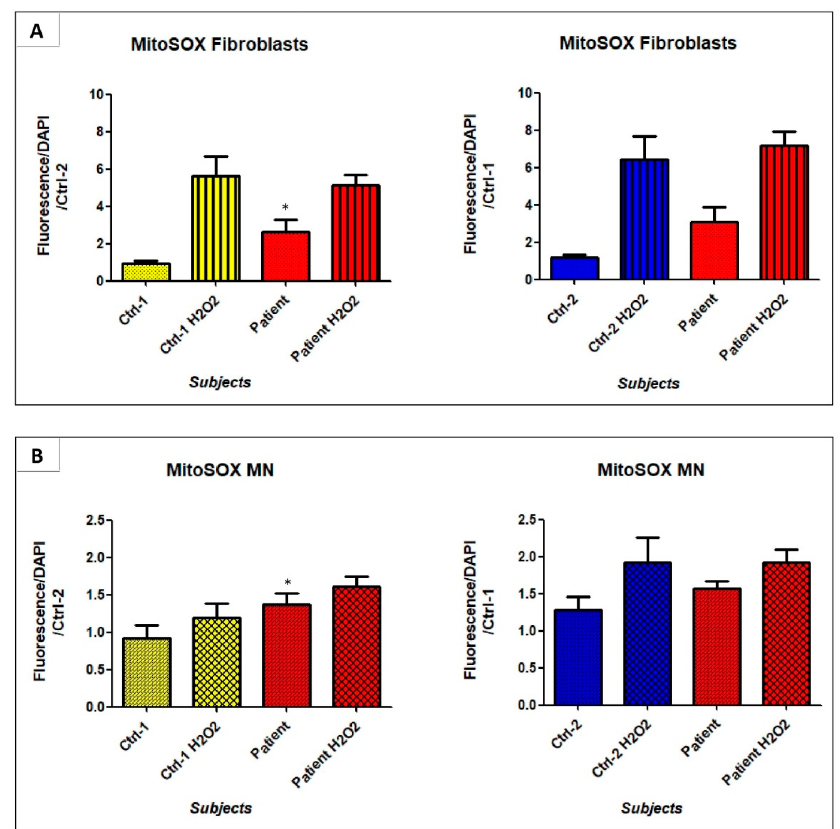
Figure 12. Superoxide anion quantification in fibroblasts ( A ) and MNs ( B ) of Ctrl-1, Ctrl-2, and patient, using the MitoSOX™ Red mitochondrial superoxide indicator. Cells treated with 1 mM H 2 O 2 , 2 h at 37 °C (fibroblasts and MN) were used as positive controls.* p < 0.05 vs. Ctrl-1.